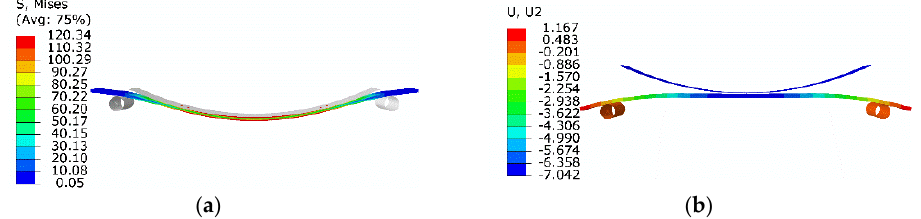
Figure 15. Numerical results of flattening: ( a ) results of the first step; ( b ) results when the pressing plate is segregated.